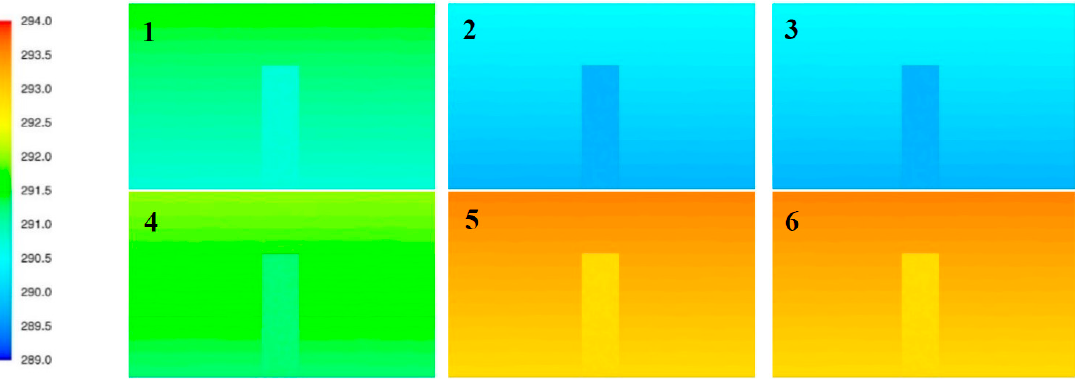
Figure 4. Initial conditions for numerical calculations—comparison of the air temperature (289–294 K) outside the chamber with the temperature of the mixture of fire-extinguishing gas and air inside the chamber; the scenario numbers refer to Table 1.